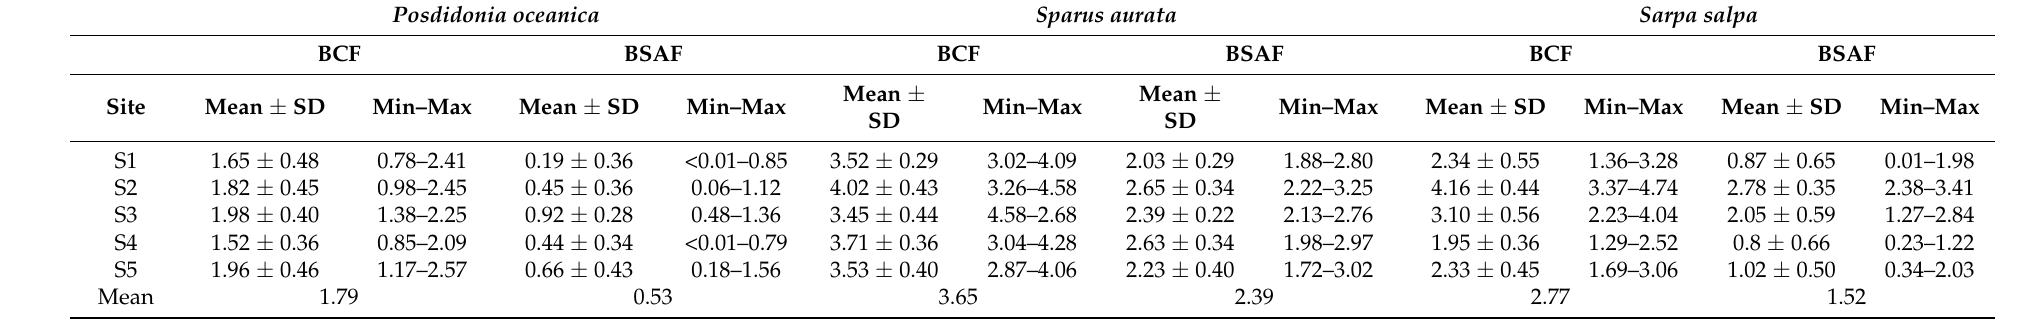
Table 3. Bioconcentration factors (BCF) and biota-sediment accumulation factors (BSAF) in leaves of Posidonia oceanica , Sparus aurata and Sarpa salpa . Posdidonia